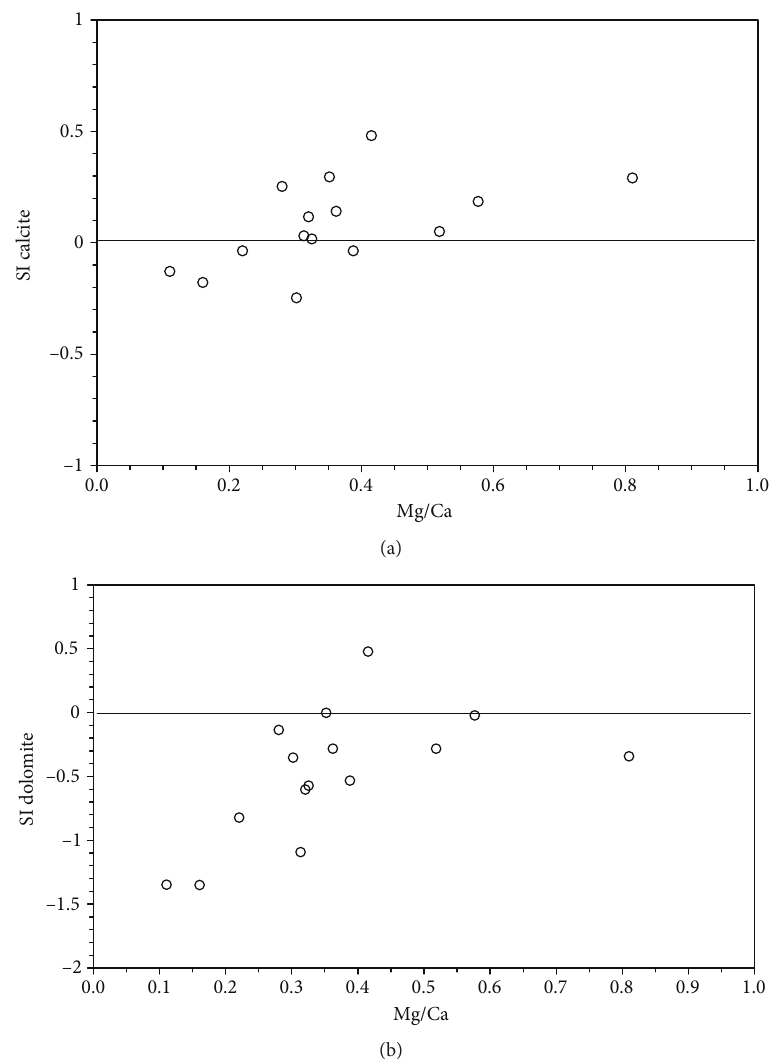
Figure 5: (Ca 2+ +Mg 2+ ) vs. HCO 3- . The dotted line shows the Ca + Mg /HCO between selected variables.